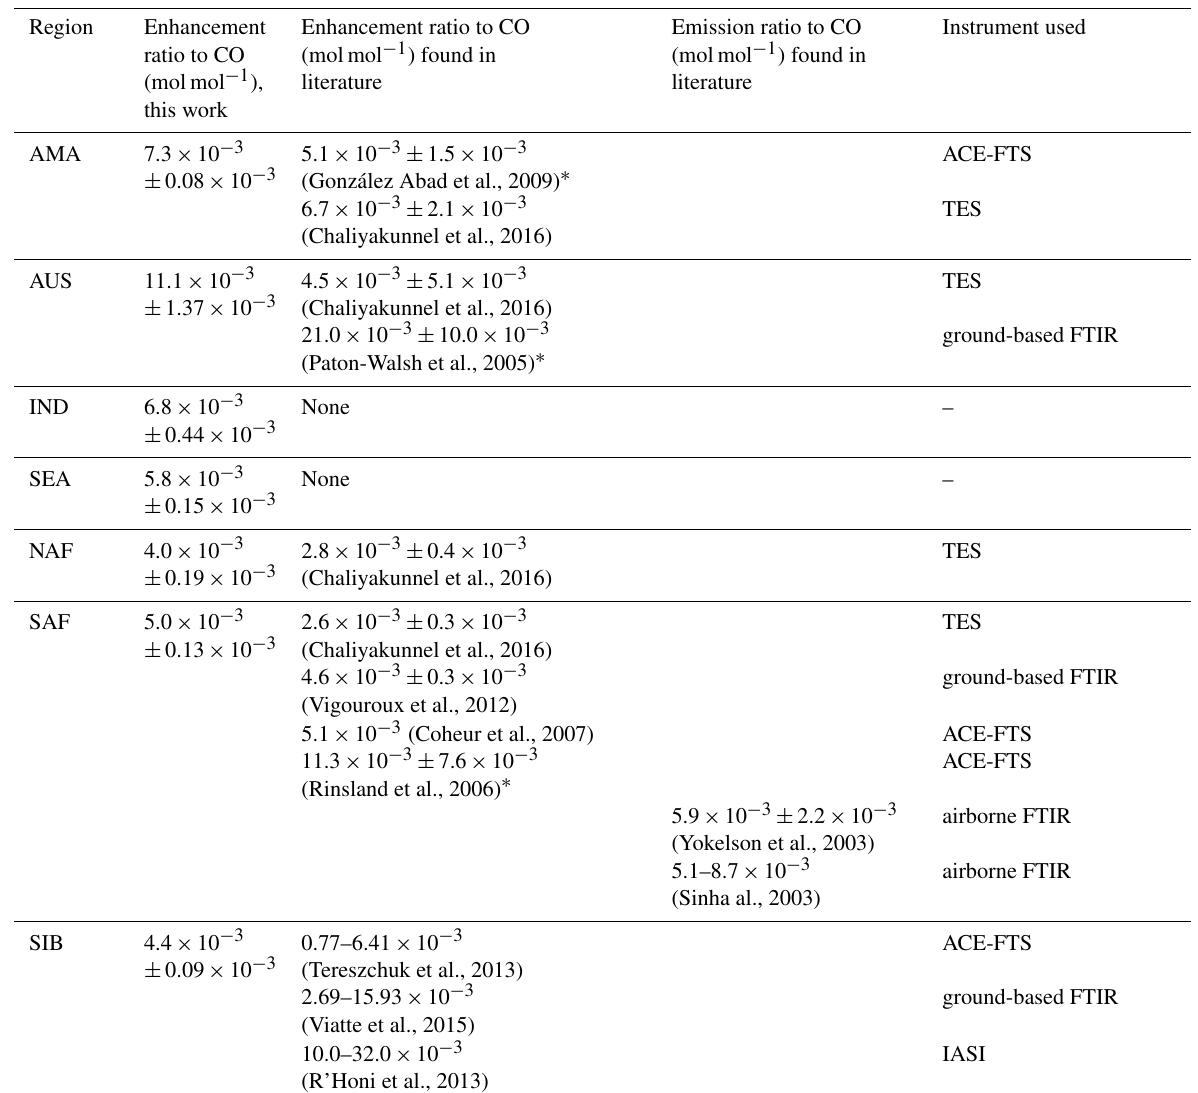
Instrument Emission ratio to CO (molmol − 1 ) found in literature